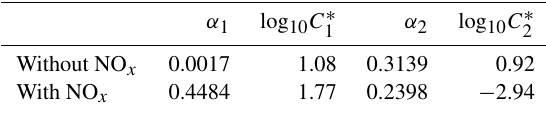
Table 3. Two-product model SOA parameters.